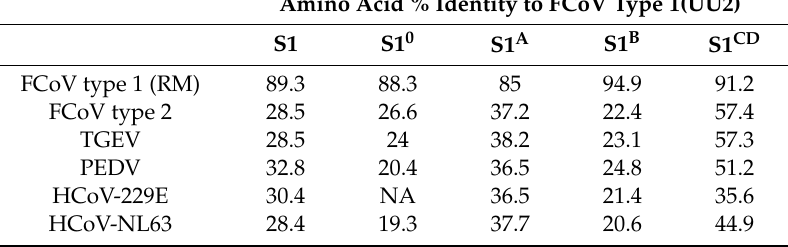
Table 3. Identities of amino acid sequences of FCoV type 1 (strain: UU2) S1 and S1 domains compared with the amino acid sequences of other alphacoronaviruses. (Identities are shown in %; NA: not available) The Genbank accession numbers of these viruses are as follows: FCoV type 1 (UU2), FJ938060.1; FCoV type 1 (RM), FJ938051.1; FCoV type 2, AY994055.1; TGEV, ABG89325.1; PEDV, AOG30832.1; HCoV-229E, NP_073551.1; HCoV-NL63,